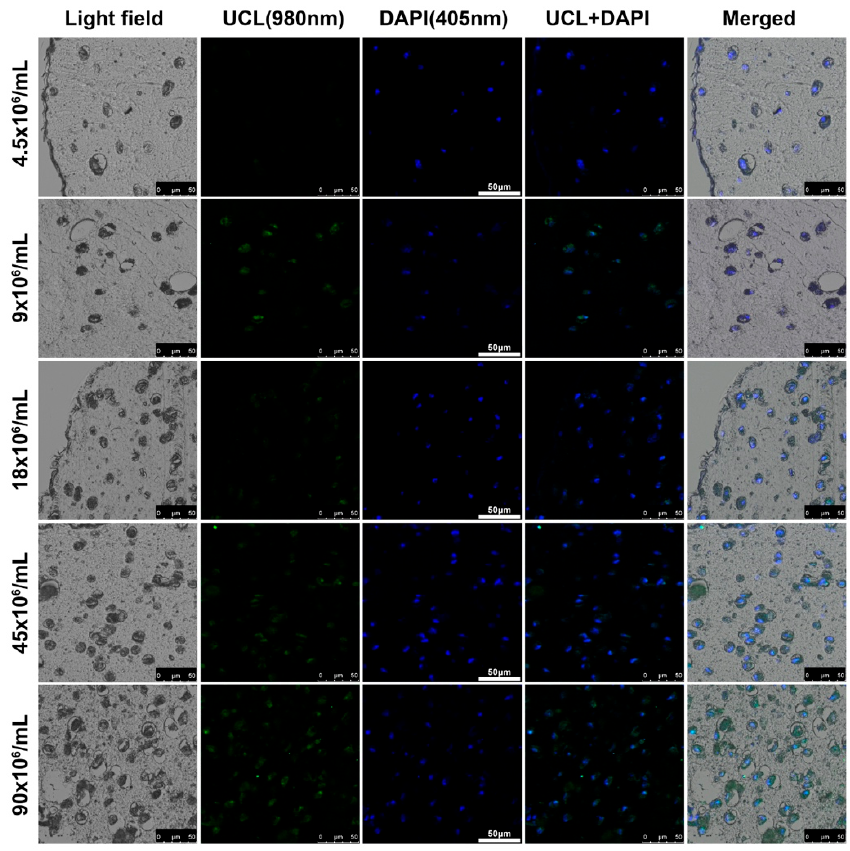
Figure 10. UCL imaging of UCNP@SiO 2 -TS of increasing concentrations (0.5 − 10 mg/mL) and hydrogel constructs containing UCNP@SiO 2 -TS-labeled CSPCs of increasing numbers (4.5 − 90 × 10 6 cells/mL). The cell nuclei are counterstained with DAPI (blue fluorescence). The UCNP@SiO 2 -TS emits fluorescence (visually blue, pseudo-colored in green) homogeneously in the cytoplasm. Scale bar: 100 µm.